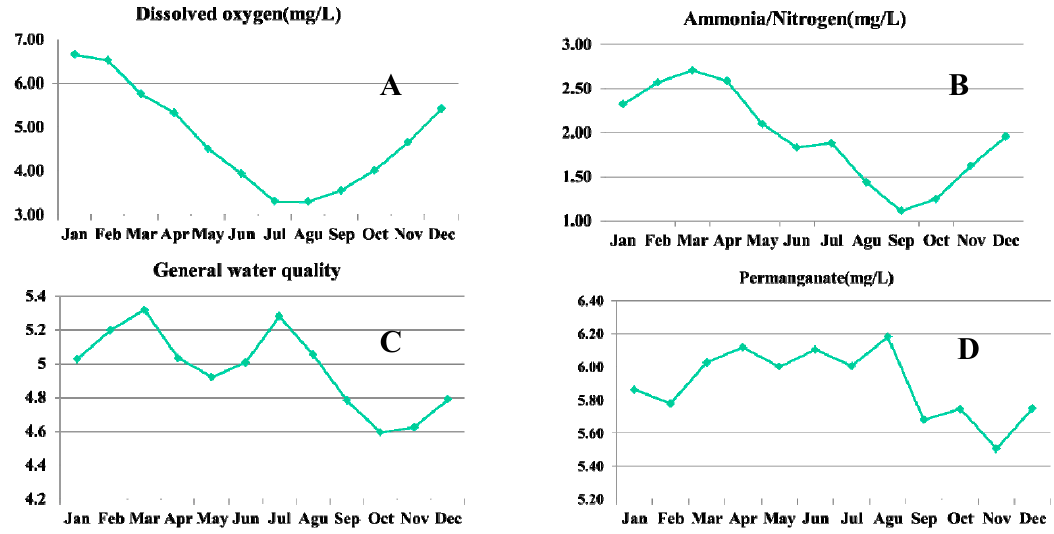
Figure 5. Seasonal changes of water quality indicators: ( A ) DO, ( B ) ammonia nitrogen, ( C ) GWQ, and ( D ) permanganate index.